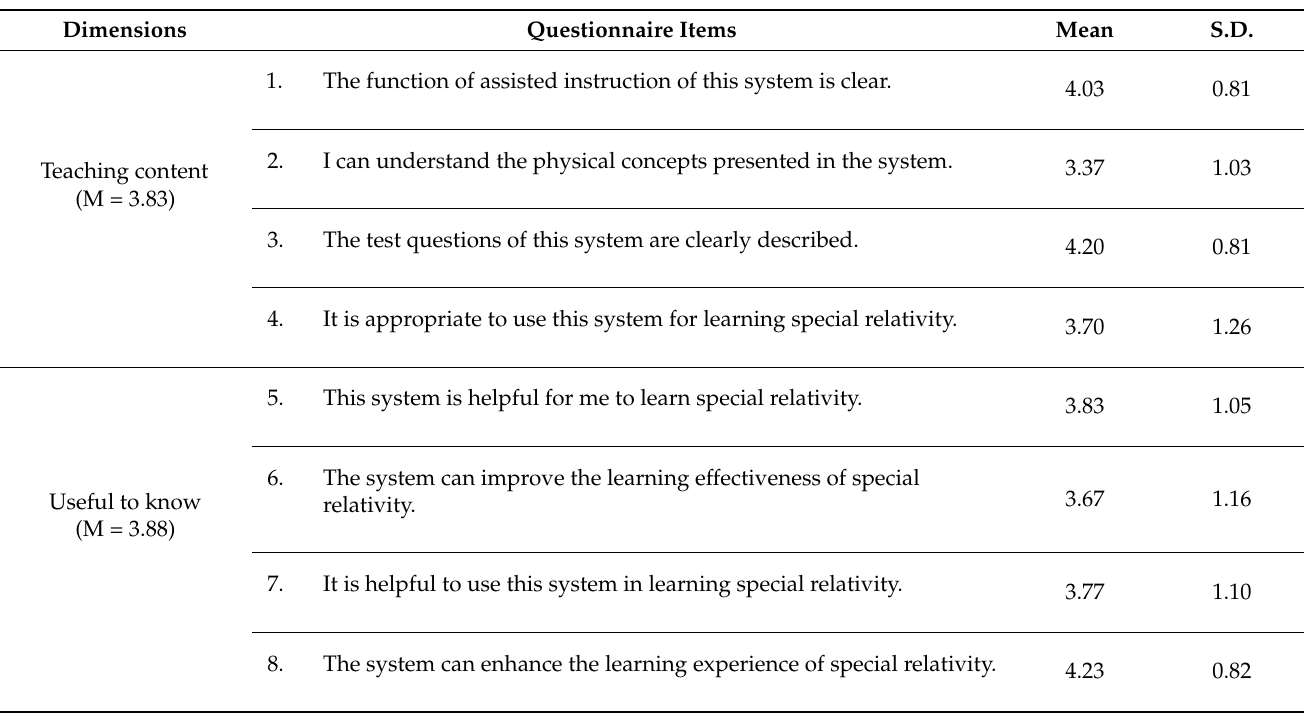
Table 9. Mean score and standard deviation of system satisfaction